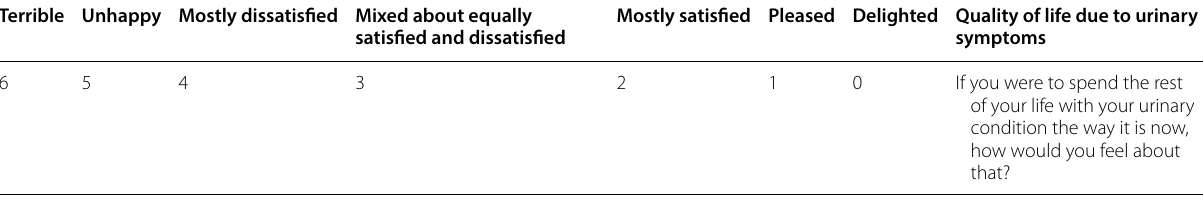
Table 1 Quality of life due to urinary symptoms questionnaire Terrible Unhappy Mostly dissatisfied Mixed about equally satisfied and dissatisfied